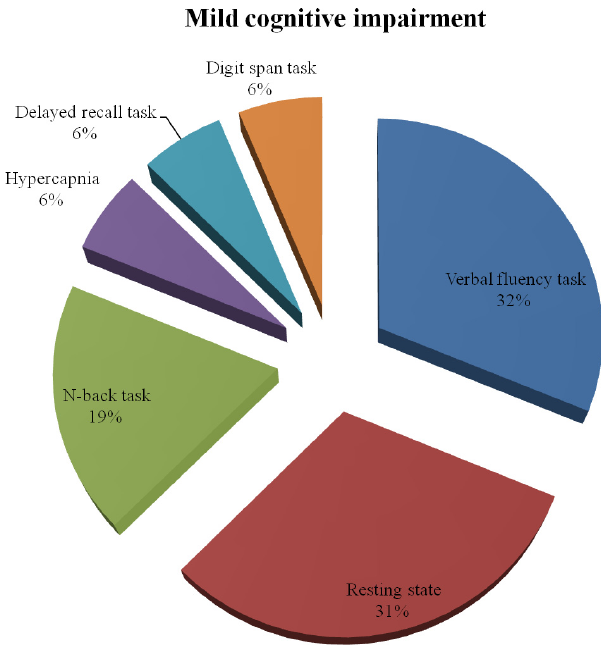
Fig. 7. Task-based distribution of studies on mild cognitive impairment (total studies: